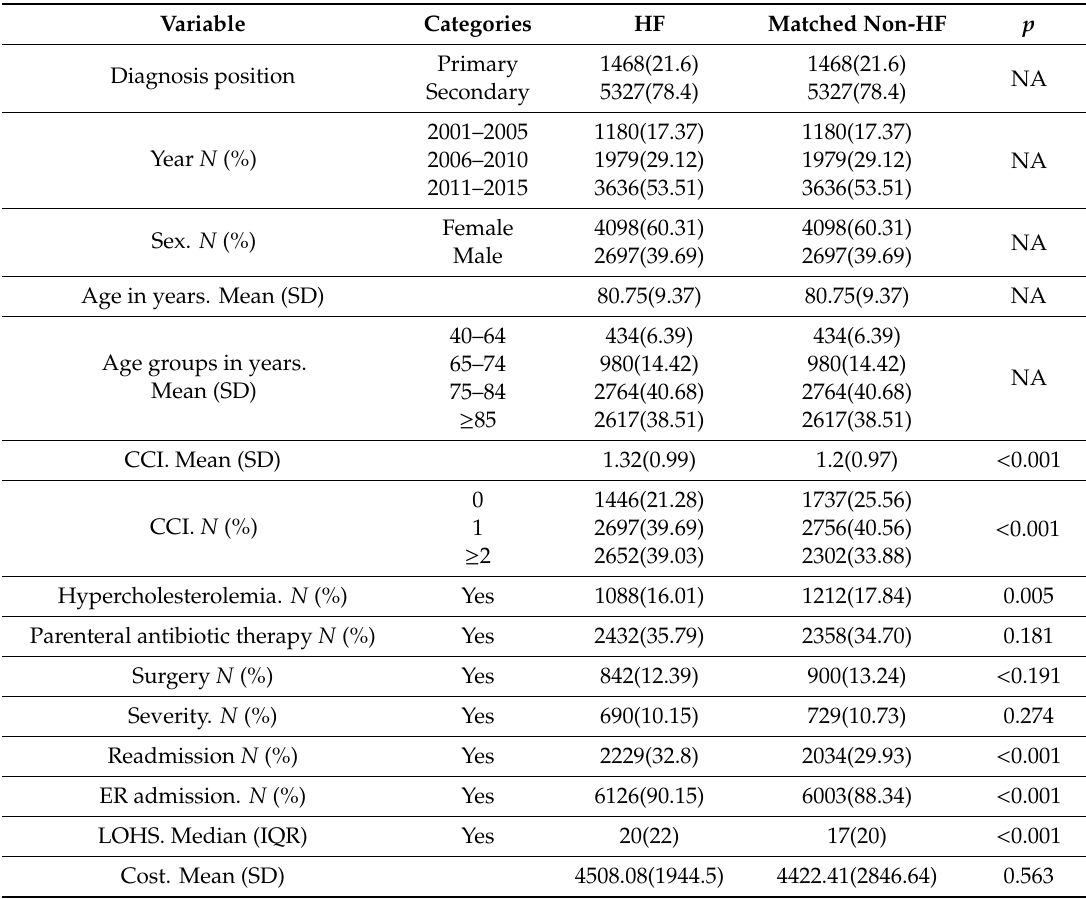
Table 3. Distribution of heart failure (HF) patients and matched non-HF controls with a diagnosis of Clostridioides di ffi cile infection according to the variables